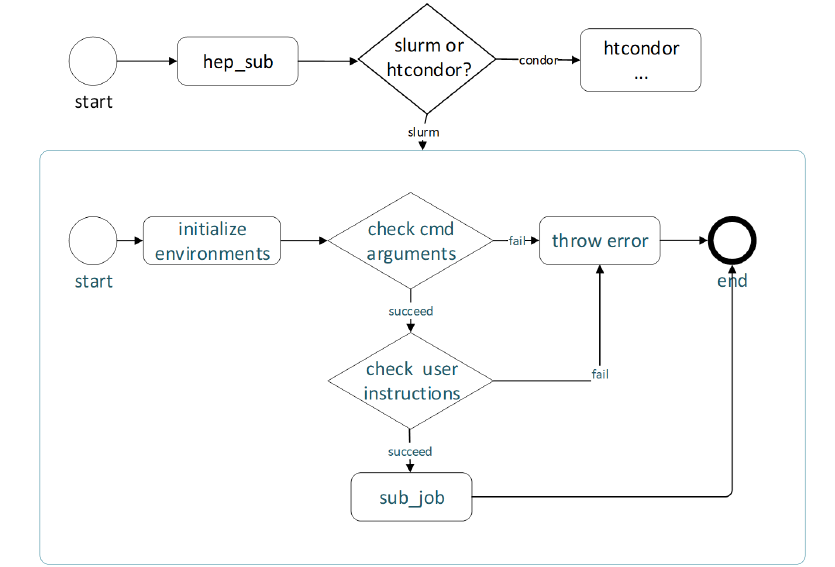
Figure 7: The Submission Workflow to